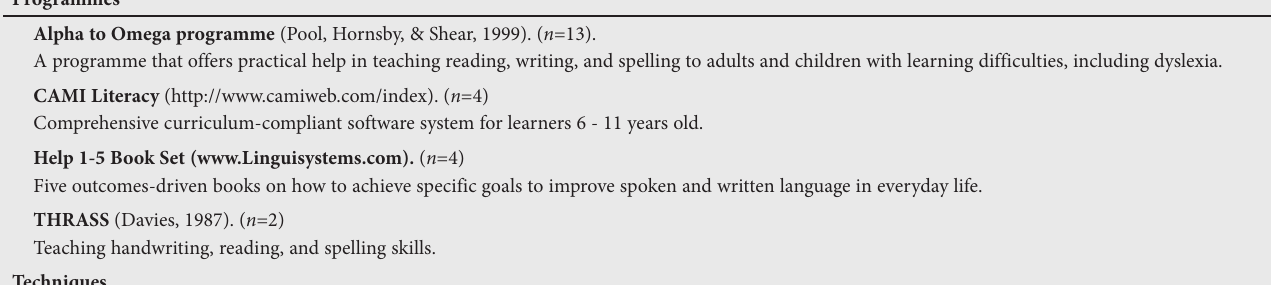
Table 1. Diff erent programmes and techniques used by respondents Programmes